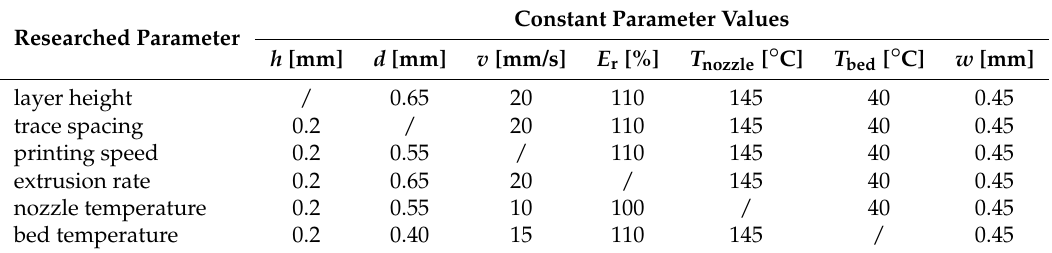
Table 2. Default values of constant parameters for every varying parameter.